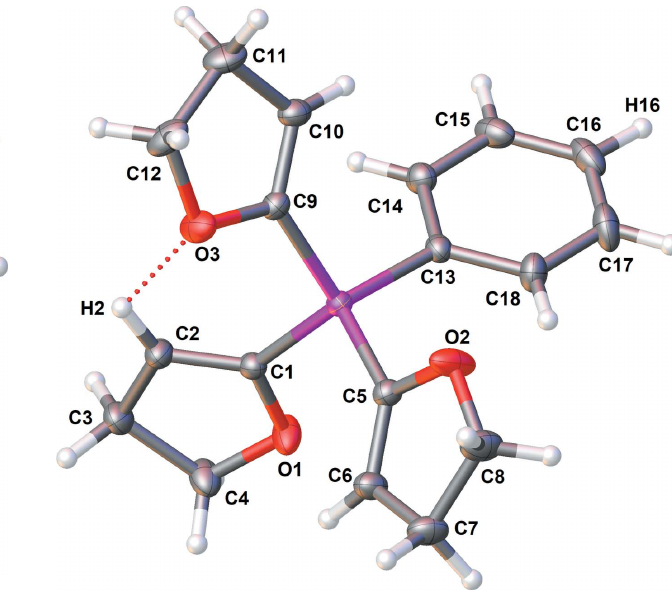
Figure 1 The molecular structure of compound 1 with displacement ellipsoids drawn at the 50% probability level.